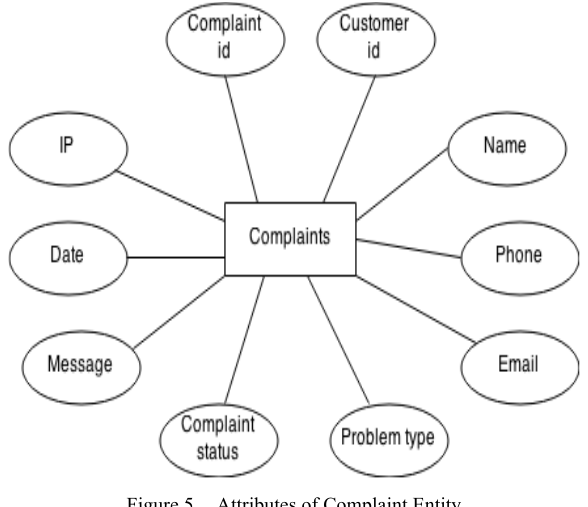
Figure 5. Attributes of Complaint Entity